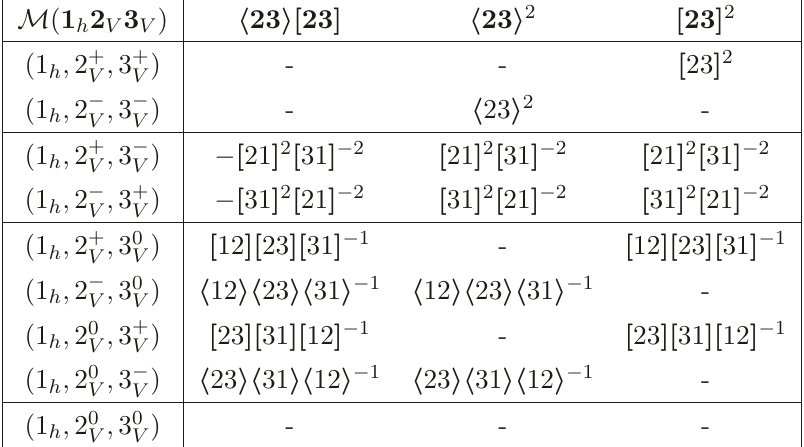
Table 5 . High-Energy limit of the three independent structures of the Entries denoted by ‘-’ appears only at order convenience, see eq. (4.4) for the full massive amplitude.